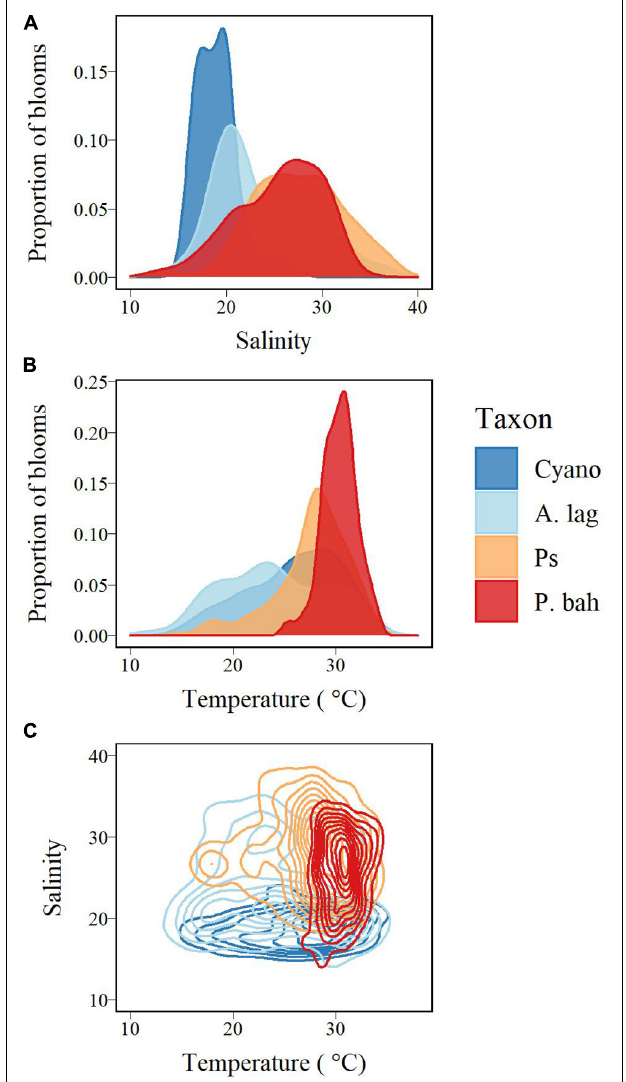
FIGURE 10 | Kernel density plots for bloom distributions of the novel cyanobacterium (“Cyano,” dark blue), A. lagunensis (“A. lag,” light blue), Pseudo-nitzschia spp. (“Ps,” orange), and P. bahamense (“P. bah,” red) for (A) salinity, (B) temperature, and (C) salinity and